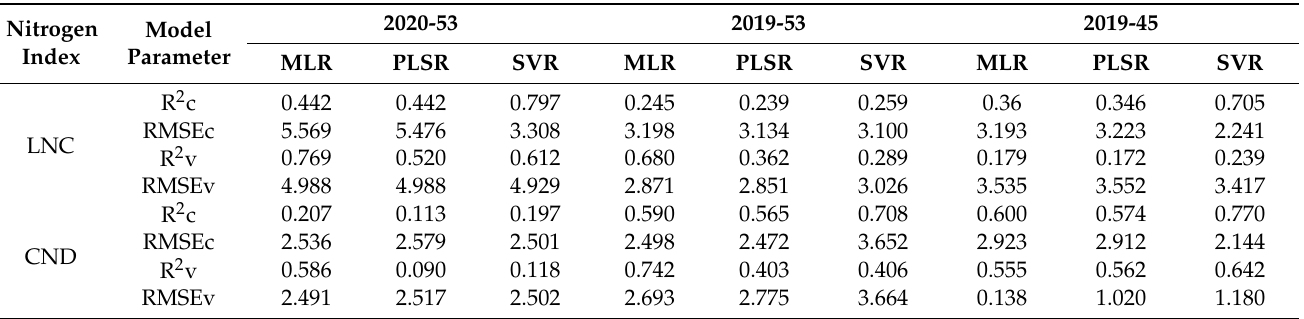
Table 8. Parameters of the nitrogen estimation model for the entire growth period of drip-irrigation cotton based on vegetation